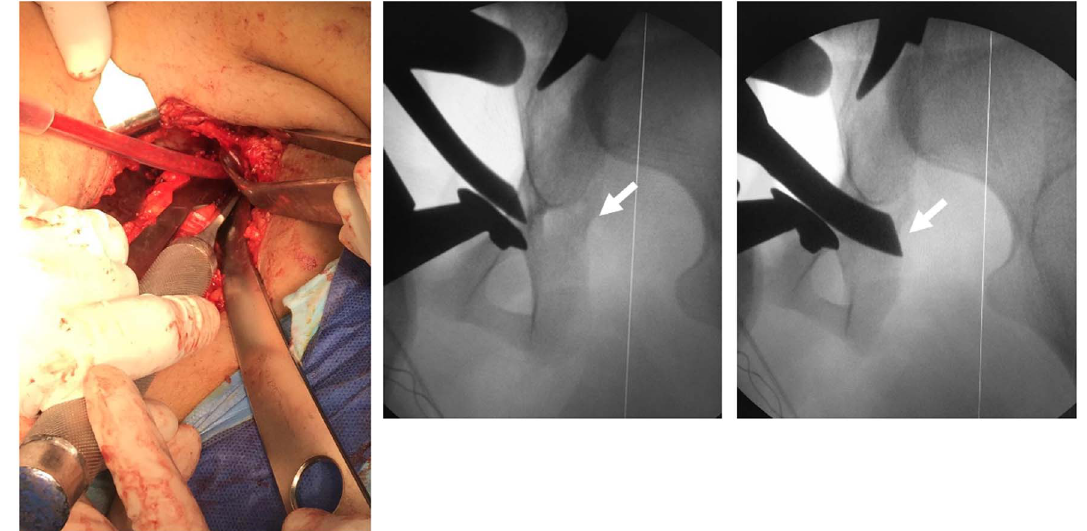
Figure 3. Performing the sub-cotyloid cut under direct vision and X-ray